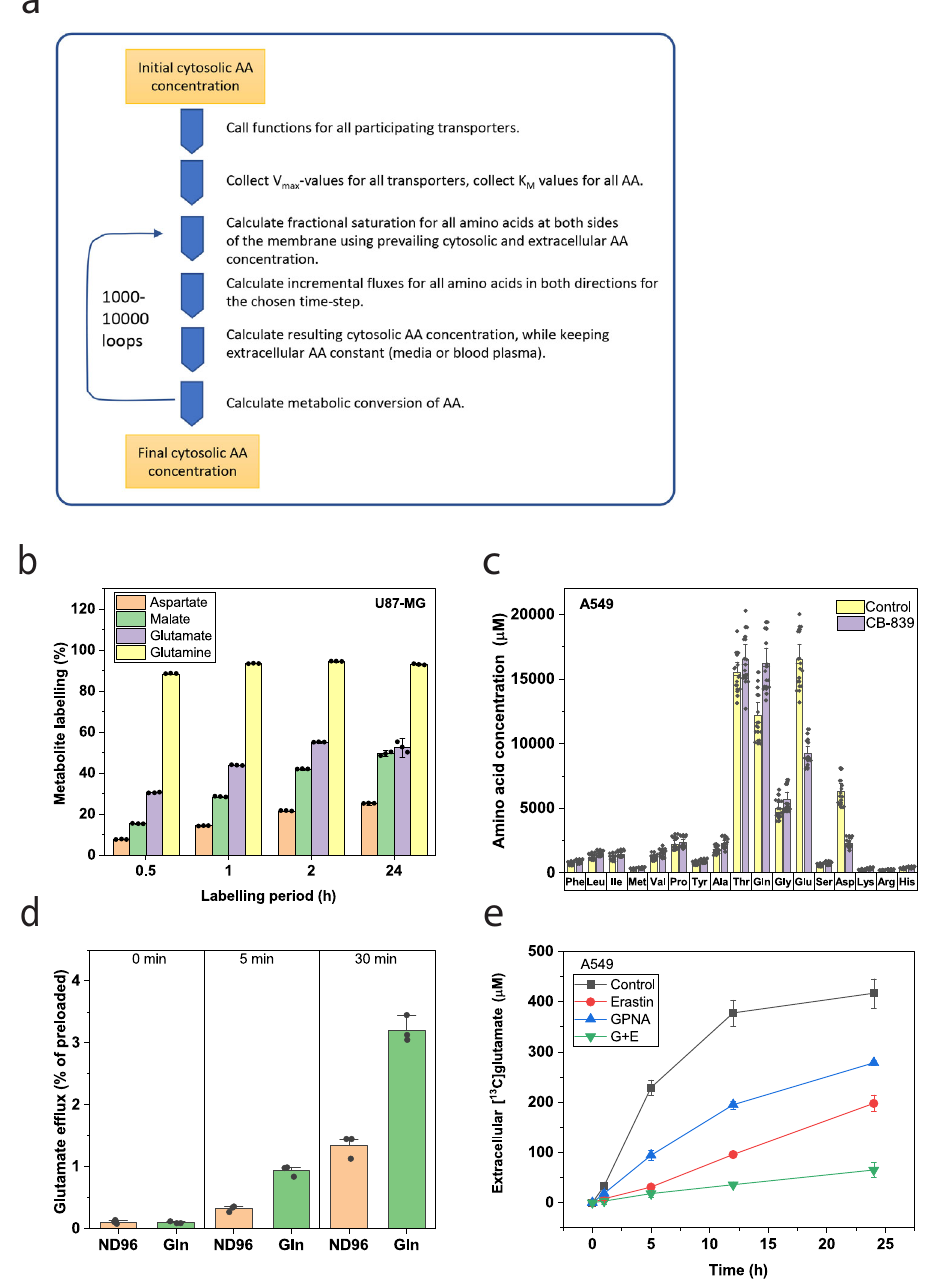
Fig. 5 Computational simulation of amino acid transport and metabolomics. a Principal steps of the transport simulation process. For details see text. b Labeling of metabolic intermediates after incubation of U87-MG cells with [ 13 C]glutamine (1 mM, 100% labeled). Enrichment of [ 13 C]metabolites is shown after 20, 60, 120 min, and 24 h ( n = 3, e = 3). c Cytosolic amino acid concentrations were determined by LC-MS in A549 cells. Glutaminase was inhibited by incubation with CB-839 (10 μ M, 1 h) and amino acid levels compared to the control ( n = 15, e = 3). d Oocytes expressing ASCT2 and EAAT1 were preloaded with 100 μ M [ 14 C]glutamate for 1 h. After washing, ef fl ux was initiated by addition of 0.5 mM glutamine (green bars) to the oocyte incubation buffer. Controls remained without addition (orange bars). Recapture of glutamate was inhibited by glutamate transport inhibitor UCPH-101 ( n = 10, e = 3). e Ef fl ux of glutamate in A549 cells was measured by feeding cells with [ 13 C]glutamine in BME medium supplemented with nonessential amino acids and detecting M + 5 glutamate in the media over time ( n = 3, e = 3). To discriminate between glutamate ef fl ux pathways, xCT inhibitor erastin and ASCT2 inhibitor GPNA were used. Data are shown as mean ± 95% con fi dence jump of cytosolic glutamate upon increasing the extracellular acids and followed amino acid changes over 1 h in A549 cells concentration of glutamate itself consistent with low levels of net (Fig. 6e – g). To evaluate the fi t of the simulation, we used a transport. quadrant plot of the log 2 (± reassigned after log conversion) of To further analyze the response of the simulation to measured ( y -axis) and simulated changes ( x -axis). The spiked extracellular amino acid changes, we added a mix of six amino amino acids were in the upper right quadrant indicating an